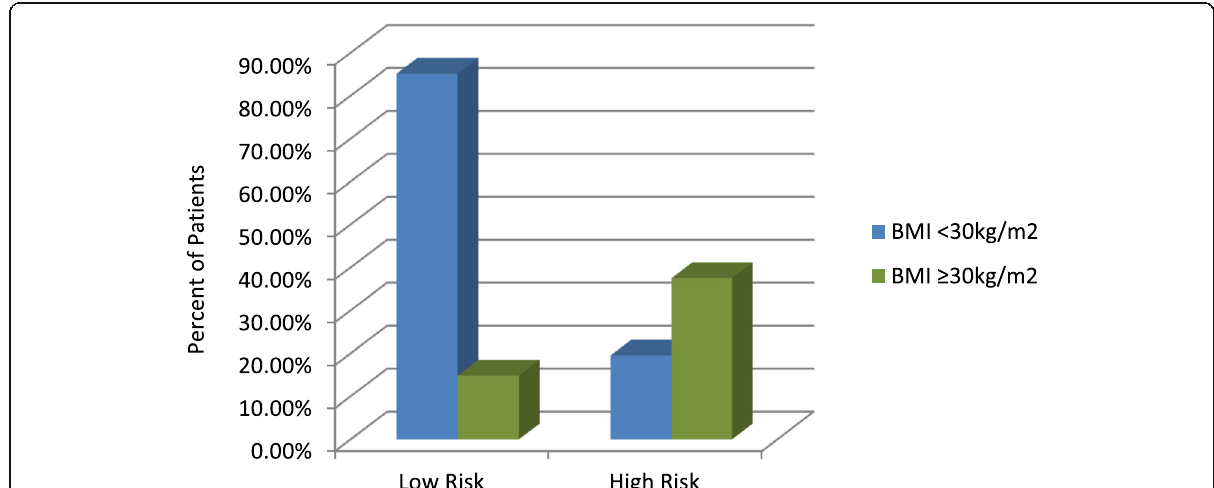
Fig. 3 Comparison between BMI and the risk of Obstructive Sleep